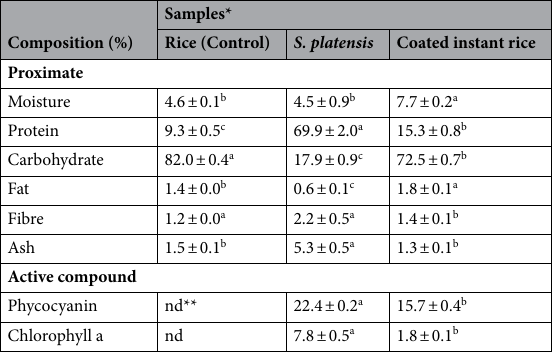
Table 3. Proximate composition of rice, S. platensis , and coated instant rice. *a–c represented the significant difference in the rows at p < 0.05. **nd means not detected.